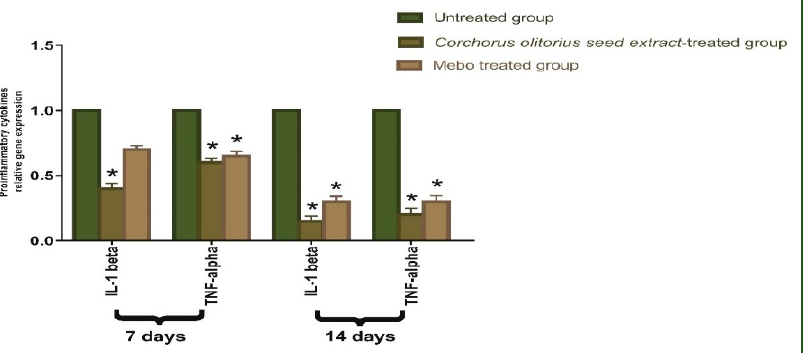
Figure 6. Gene expression in wound tissues for rabbits of different groups. Quantitative RT-PCR was used to evaluate the gene expression in wound tissues for rabbits of different groups. Data represent fold change relative to the normal control group expression after normalization to glyceraldehyde 3-phosphate dehydrogenase ( GAPDH ). Bars represent mean ± SD. Significant difference between groups is analyzed by a two-way ANOVA test, where: * p ≤ 0.001 compared with those of the untreated group on the respective days.